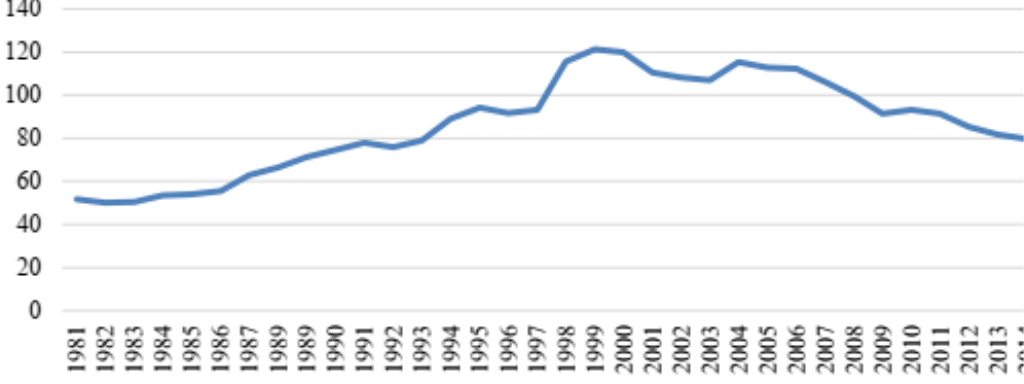
Figure 2: Exports (% of GDP) of Malaysia